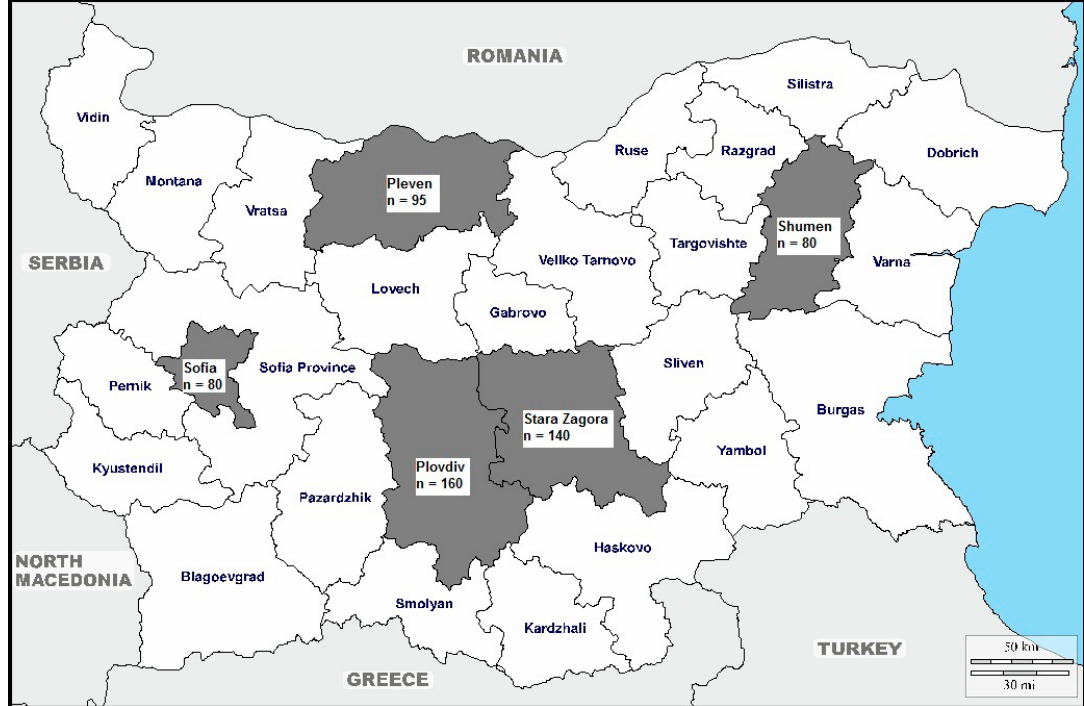
Figure 1. Geographic distribution of the Bulgarian blood donors by district (in gray).